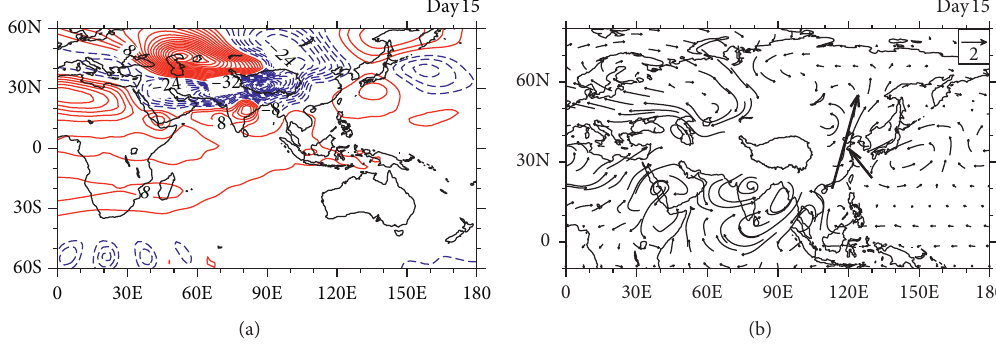
Figure 9: (a) 200hPa height (contours, units: gpm) and (b) 850hPa wind (vectors, units: m · s − 1 ) anomalies generated by COM experiment on day